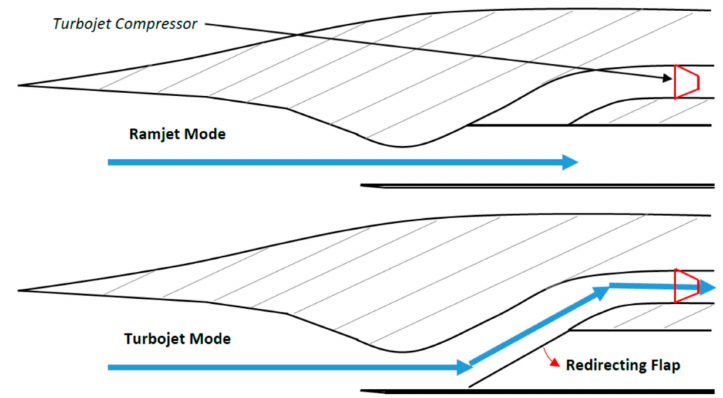
Figure 21. Over/under combined cycle engine investigation.